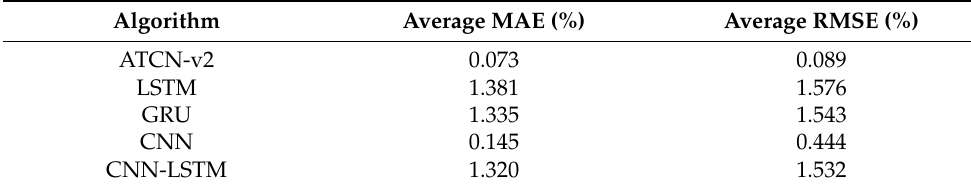
Figure 10. SOC estimation errors of the different algorithms for five types of batteries (LR1865EH, LR1865SK, LR1865SZ, LR2170SA, and ICR18650): ( a , b ) average MAE and average RMSE under − 20 °C; ( c , d ) average MAE and average RMSE under 25 °C; ( e , f ) average MAE and average RMSE under 60 °C. Table 4. SOC estimation performance of the different